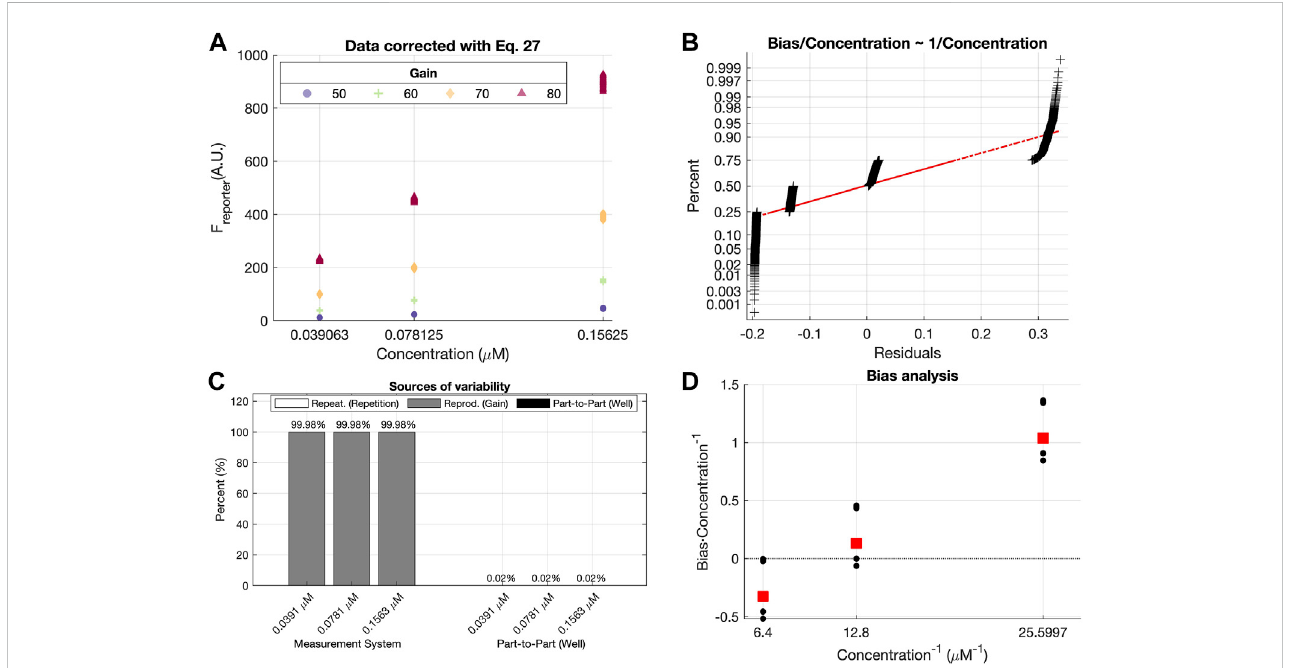
FIGURE 8 Results obtained withafter usingCalibrationdatasetbeforeandafter correctionwithEq. 27. (A) F reporter valuesassumingalinear effectofthegainonthe fl uorescence measurements. Marker shapes and colors depend on the Gain level G used. (B) Normal probability plot of the scaled residuals after using the f expression from Eq. 27 to predict the concentration. R&R (C) and L&B (D) analyses of the validation data set after using the f G correction from Eq.